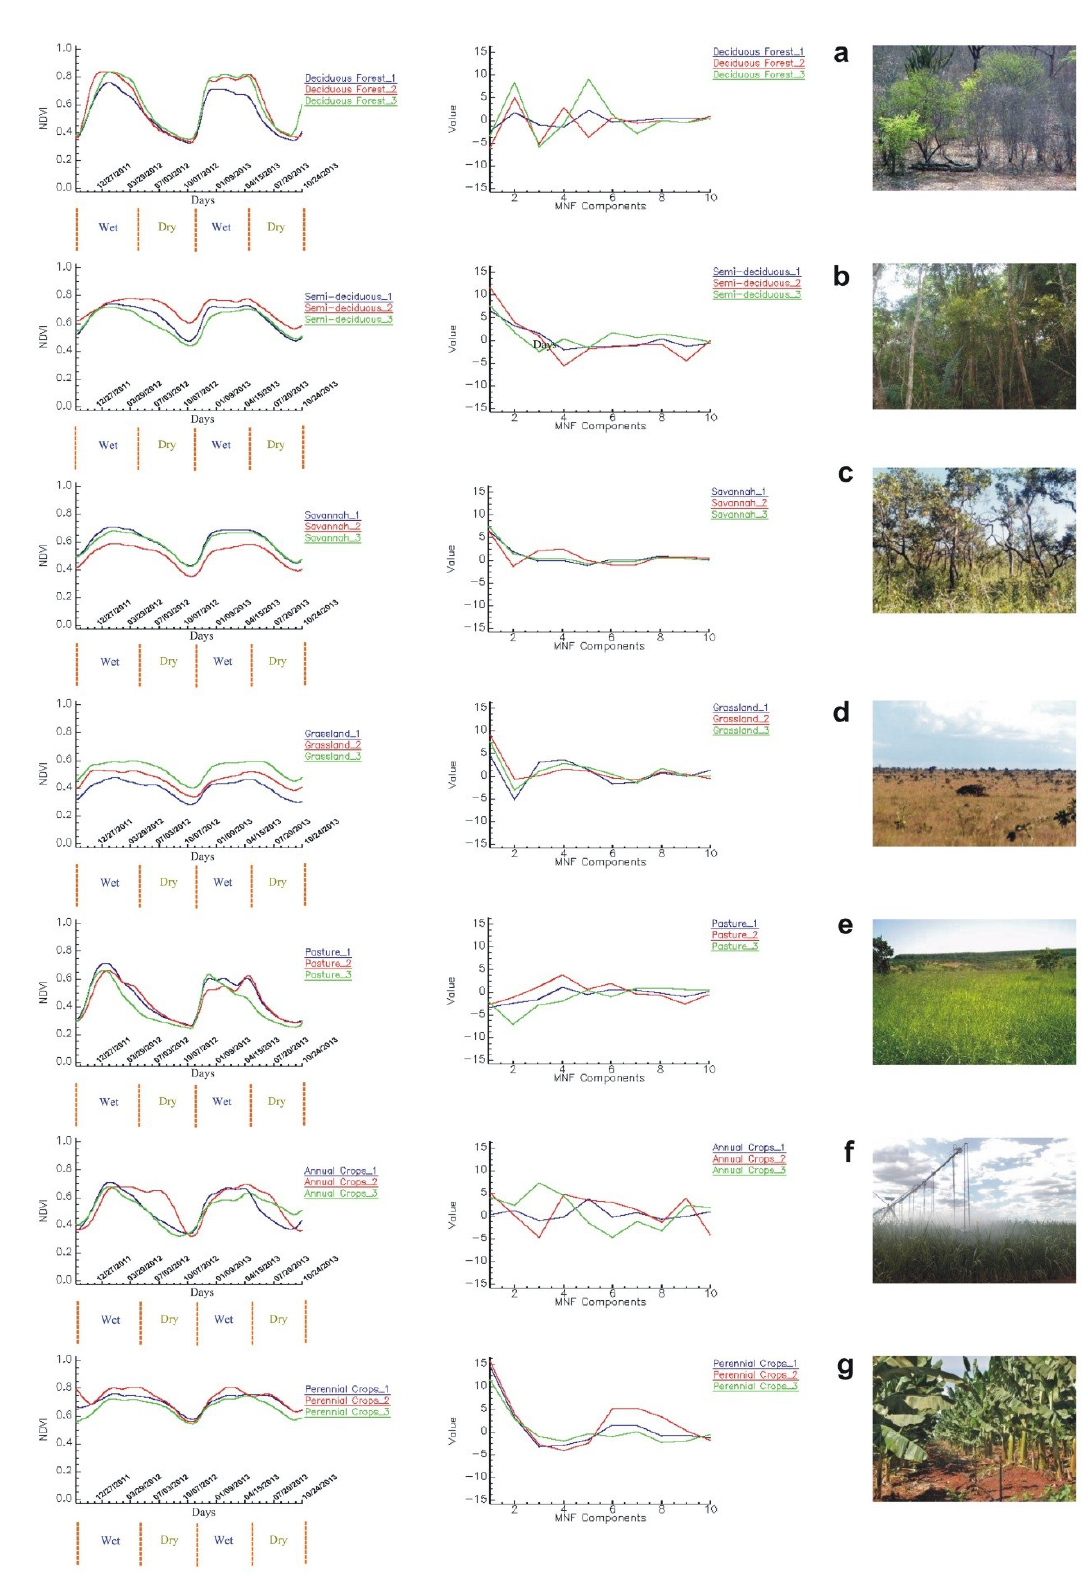
Figure 6. Temporal signatures from the MODIS-NDVI time series and the MNF signal components: ( a ) deciduous seasonal forest, ( b ) semi-deciduous seasonal forest, ( c ) savanna woodland (Cerrado stricto sensu ), ( d ) grassland formations, ( e ) pasture, ( f ) annual crops, and ( g ) perennial